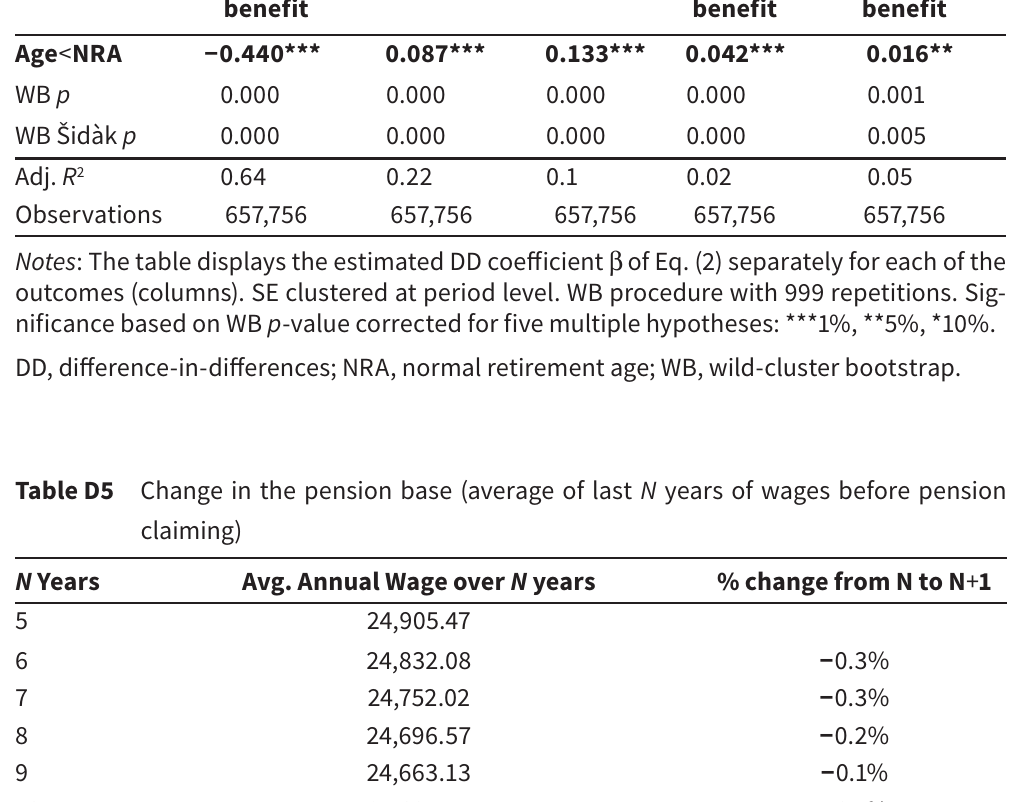
Table D4 Effect of raising the NRA: Eq. 2 excluding individuals with < 15 years of contributions in 1992 Pension Employment benefit